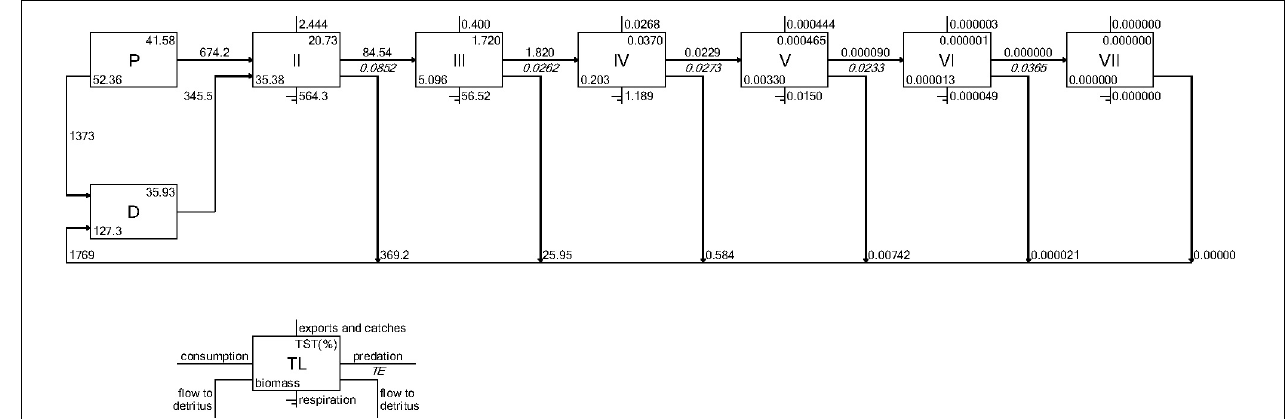
FIGURE 8 | Example Lindeman Spine diagrams from the June 2010 Ecopath model determined from time slices from the Ecosim calibration simulation. Biomasses are in t km − 2 and flows are in t km − 2 year − 1